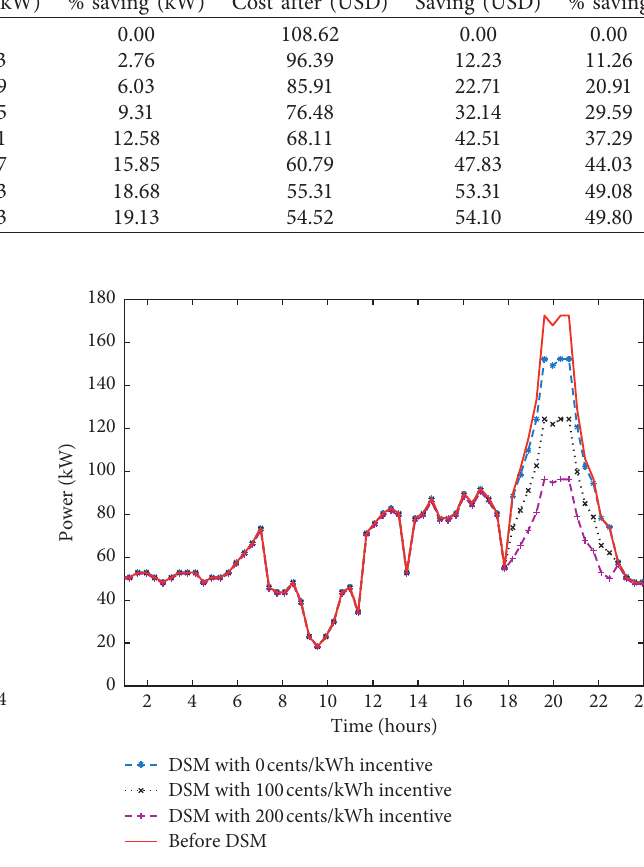
Figure 7: Load profile before and after implementation of LS DSM with different values of incentives.